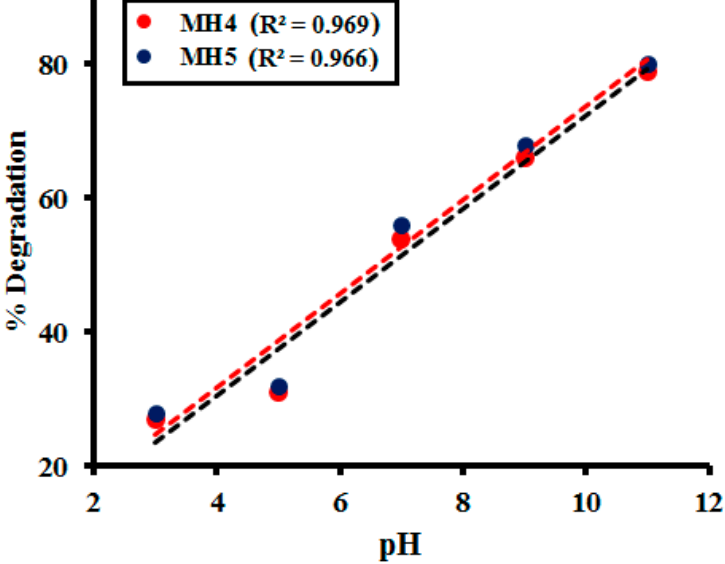
Figure 10. Photocatalytic degradation of alizarin red (AR) dye (250 ppm) after 60 min employing different pH by 0.025 g of MH1 and MH5.